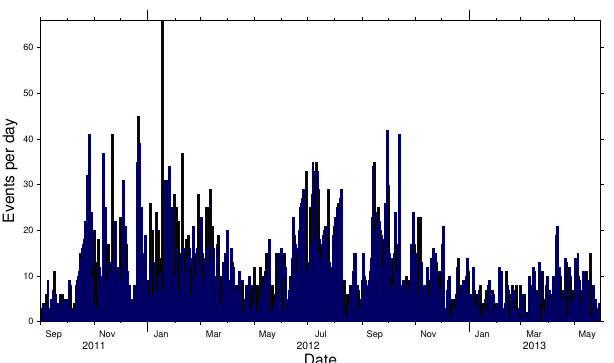
Fig. 8. Evolution of the daily rate of hybrid, cigar-shaped and long- period events recorded on Fogo between September 2011 and May